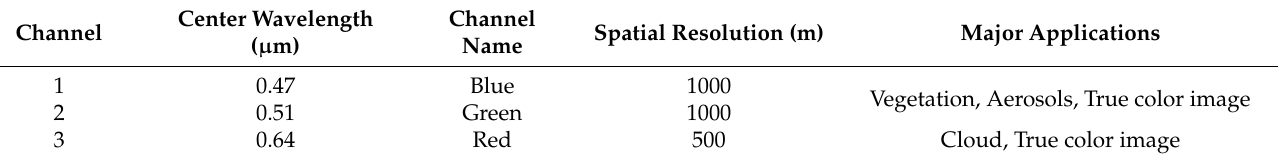
Table 1. Advanced Himawari Imager characteristics and their major applications.